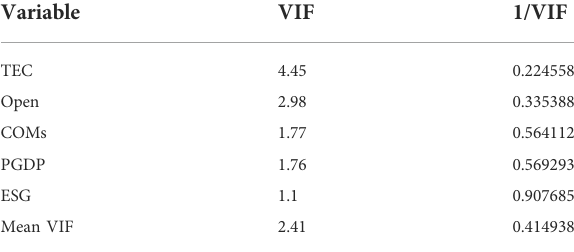
TABLE 3 VIF test for explanatory